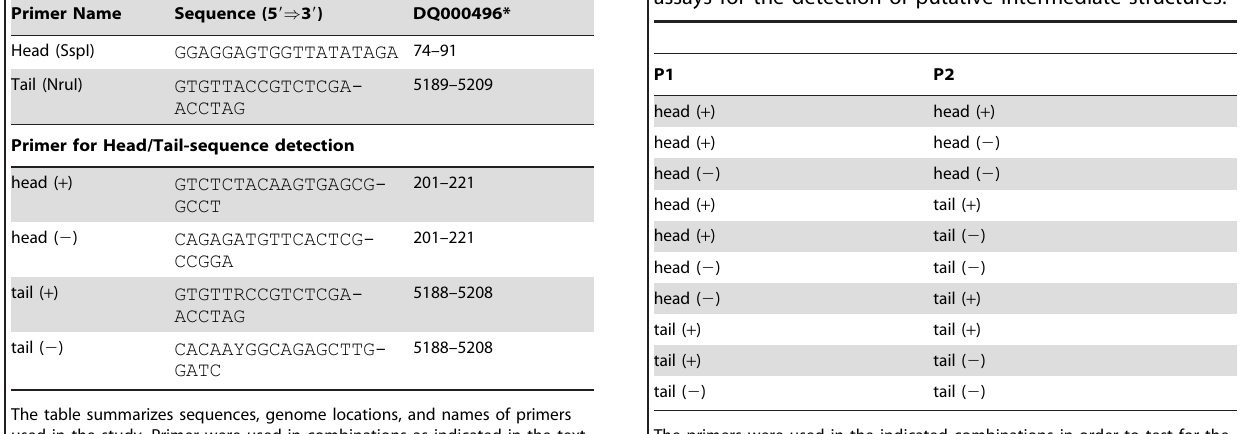
Table 3. Primer combinations used in the amplification assays for the detection of putative intermediate